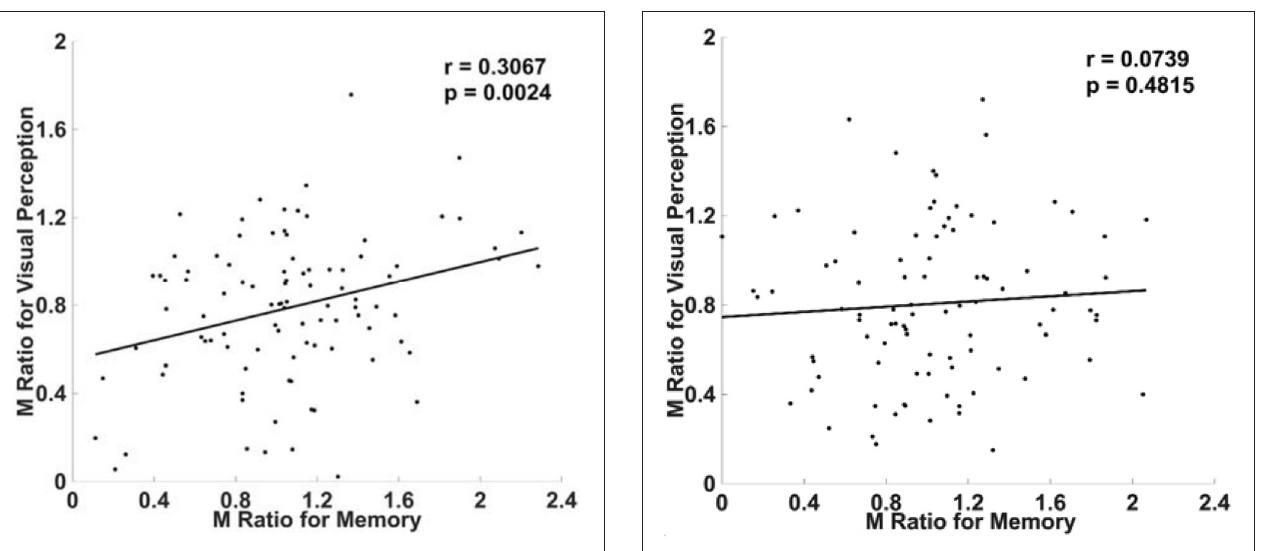
FIGURE 3 | No correlation in metacognitive efficiency when the visual task involved 2AFC judgments and the memory task involved YN judgments. As in Baird et al. (2013), we didn’t find a correlation between visual and memory metacognitive efficiency when the visual task involved 2AFC judgments and the memory task involved YN judgments. As in Experiment 1, metacognitive efficiency was quantified using M Ratio (see section Materials and